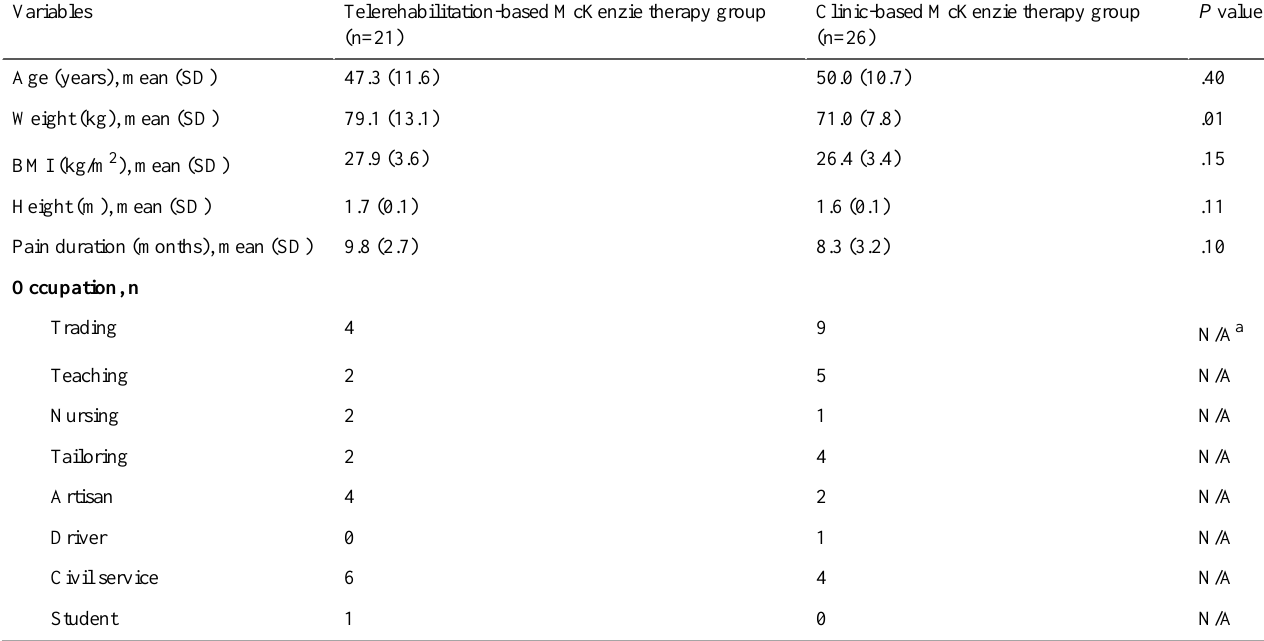
Table 1. Baseline characteristics of the telerehabilitation-based McKenzie therapy group and clinic-based McKenzie therapy